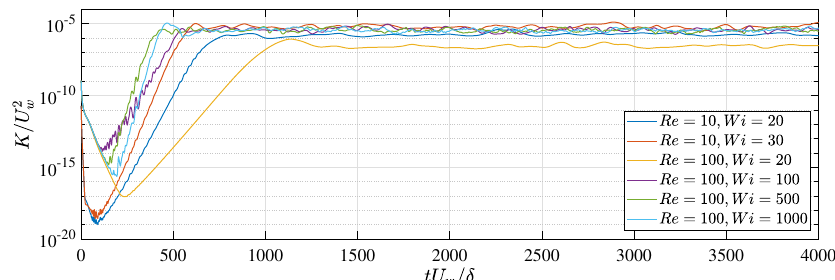
Figure 3. Time series of kinetic energy K for typical cases of Re and Wi